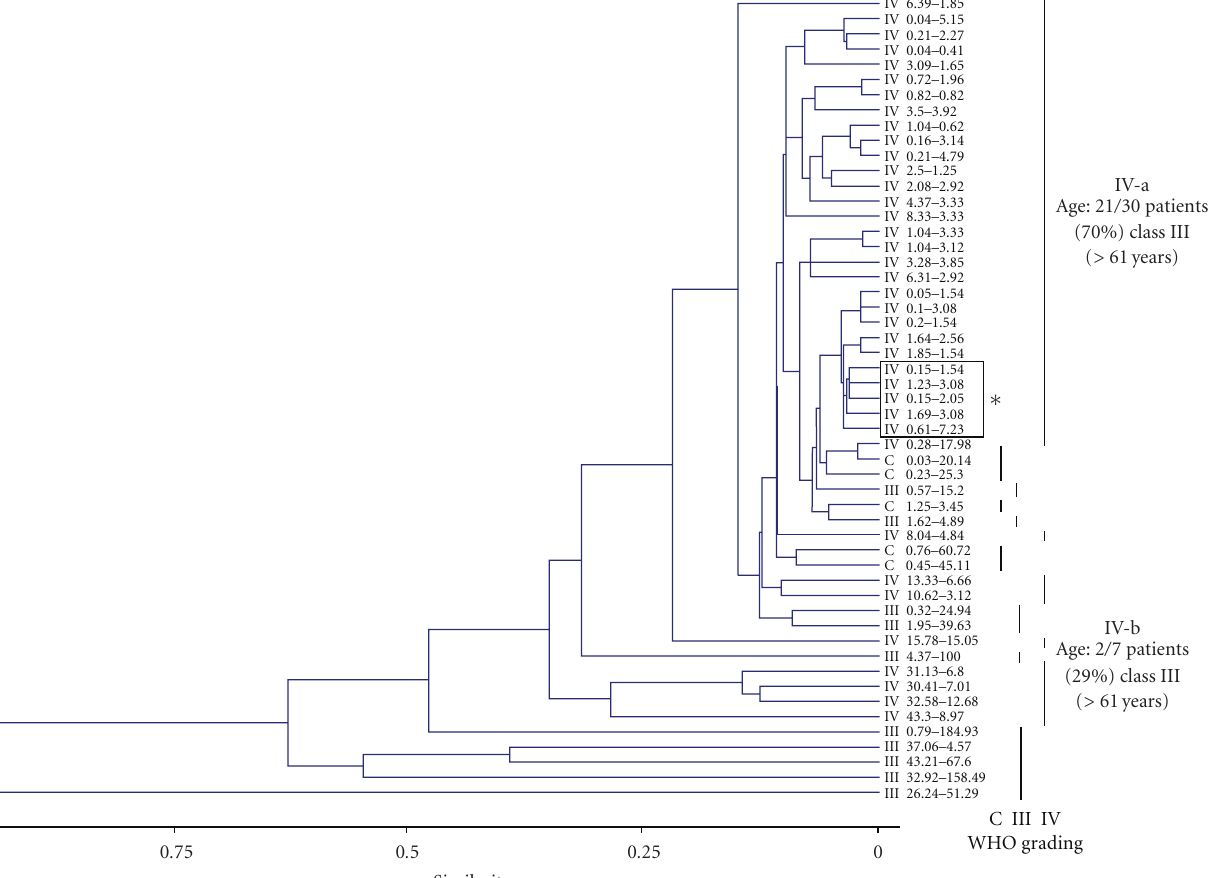
Figure 3: Dendrogram comparing PTEN and MMP9 absolute quantitative expression. Absolute quantifications are expressed in femtograms, as reported in Materials and Methods. WHO grades of malignancy (III, IV) and healthy brain control (C) specimens are indicated. Glioblastoma multiforme subgroups IV-a, including the majority of glioblastoma specimens, and IV-b, described in Results, are highlighted. The box ( ∗ ) indicates subgrouping of patients sharing similar tumor anatomical localization (i.e., temporal). Subgroups IV-a and IV-b have a di ff erent and significant distribution of age-class III patients ( > 61 years, P < . 01 Anova-one